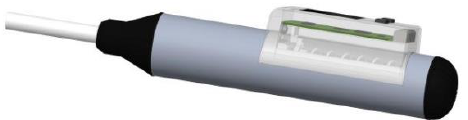
Figure 4. The schematic view of intelligent rebound hammer.